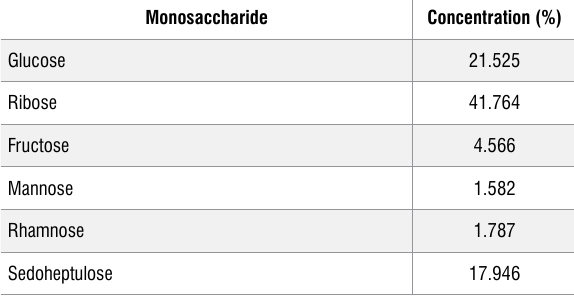
Monosaccharide content of yellow variety of tiger nut